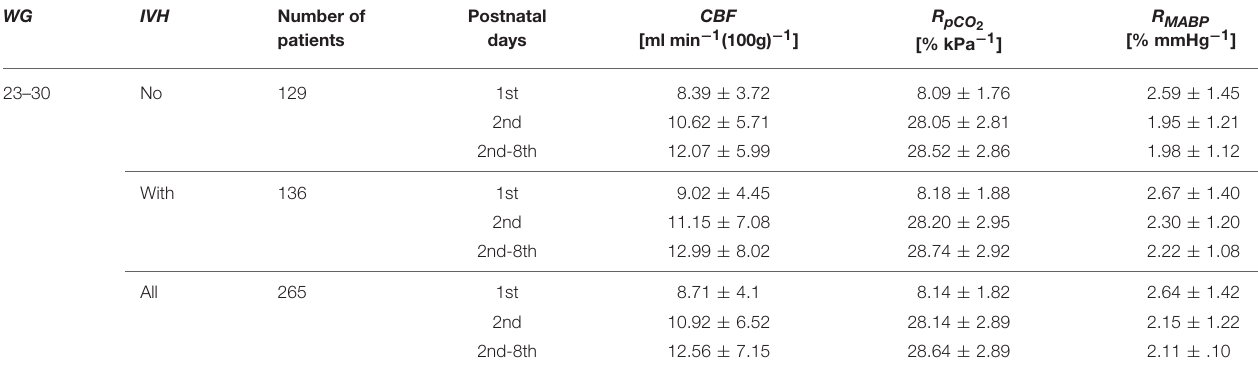
) and MABP (R MABP ) . 2